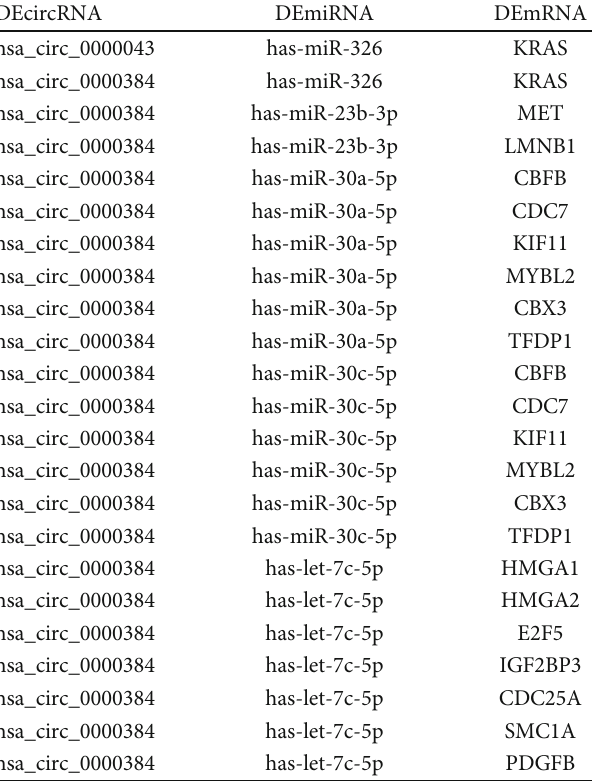
Table 3: The DEcircRNA-DEmiRNA-hub gene